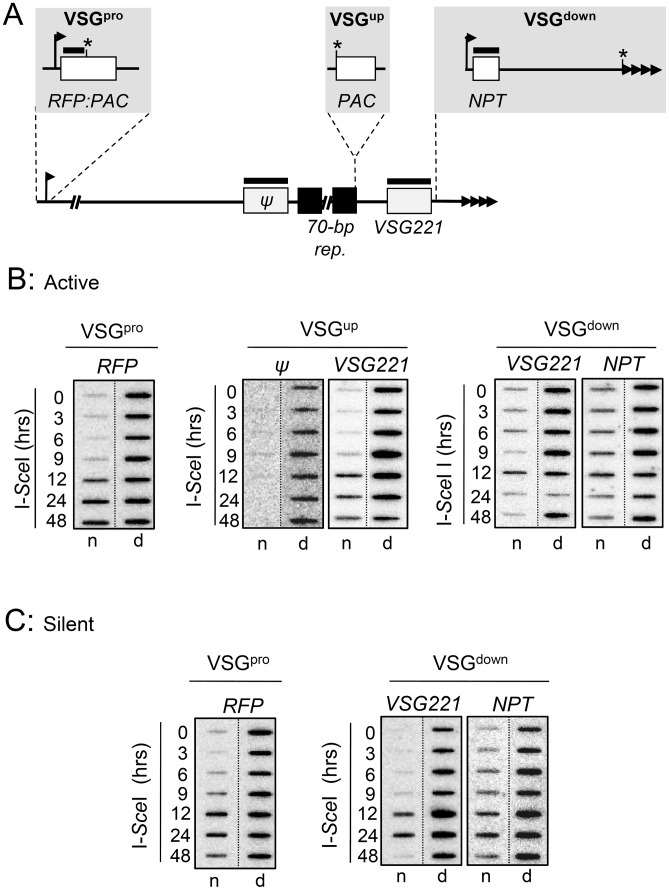
DNA double-strand breaks initiate DNA resection at active and silent VSG expression sites.(A) The schematic indicates the location of the I-SceI cleavage sites (*) and probes (bars). Other details as in Figure 2A. (B) Assays in strains with an active VSG221 BES. Genomic DNA samples were extracted at the times indicated following I-SceI induction, and ssDNA was monitored on slot-blots. Ninety percent of each sample was ‘native’ (n) and the remaining 10% denatured (d) as a ‘loading’ control. (C) Assays in strains with a silent VSG221 BES. Other details as in B above.